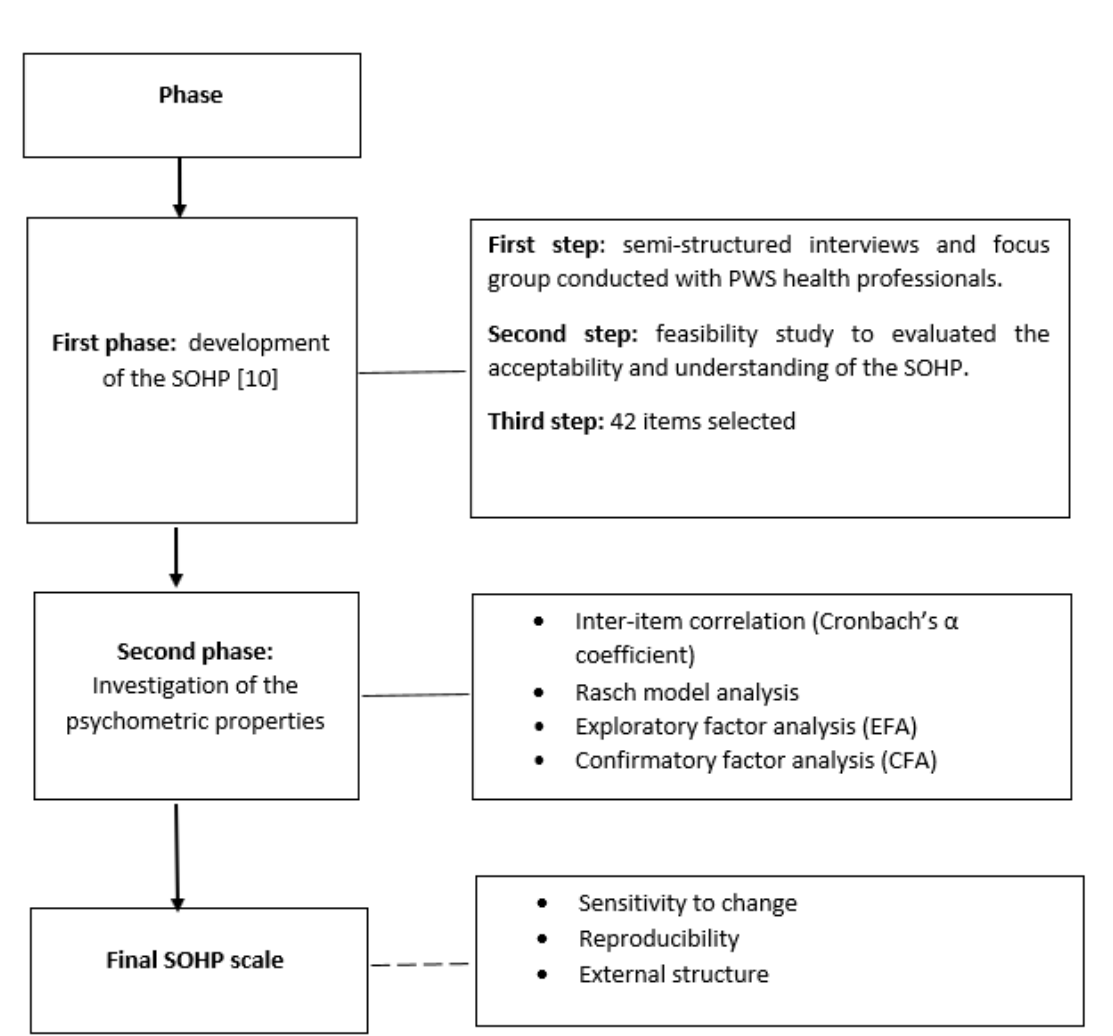
Figure 1. Process of program development and psychometric testing. SOHP: Schizophrenia Oral Health Profile; PWS: people with schizophrenia.